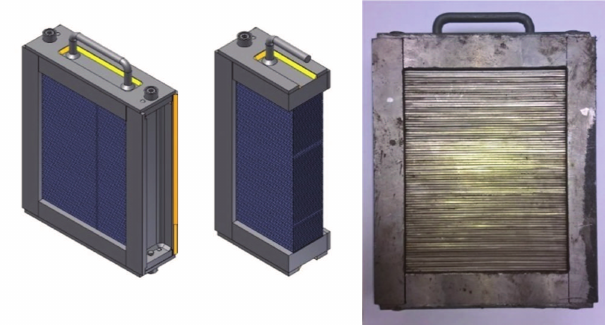
Fig. 3. Function element of a flame arrester, model (left), real view ( right) [5]